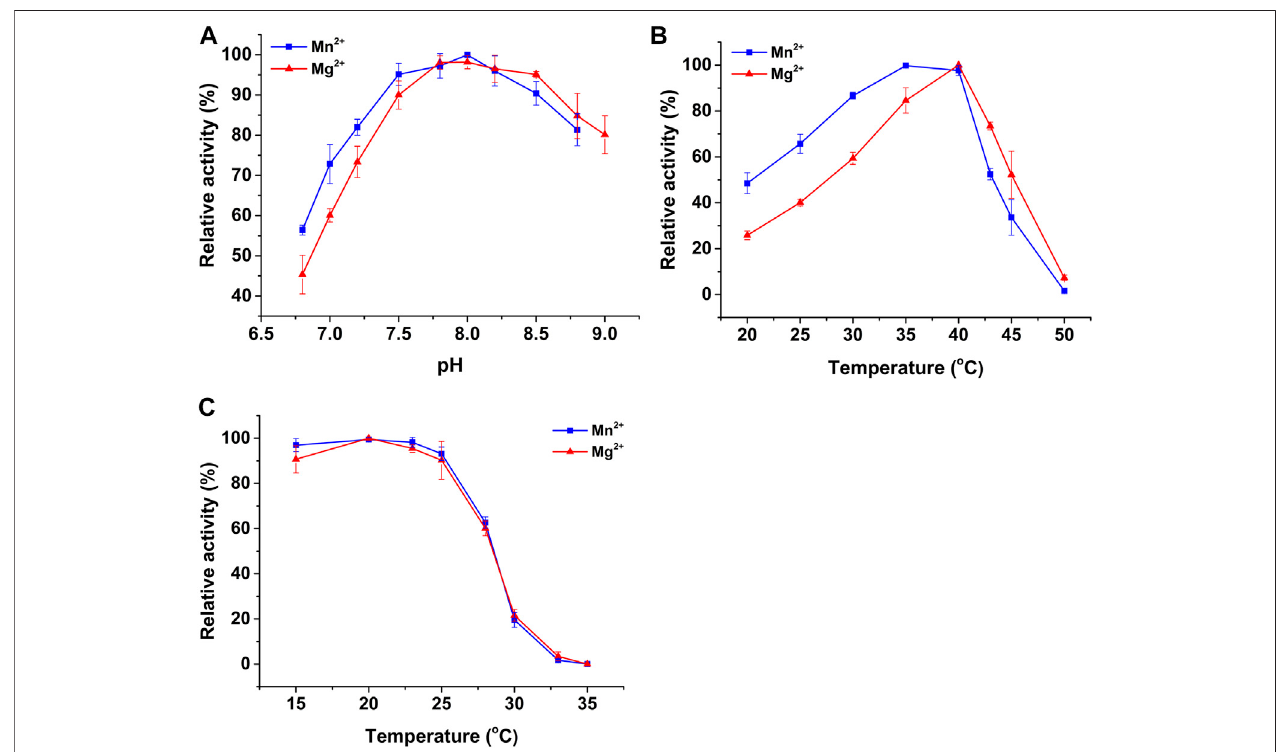
FIGURE 4 | The effects of pH and temperature on the NADP + -linked activity of PtIDH2 in the presence of Mn 2+ (blue squares) and Mg 2+ (red triangles). (A) The effects of pH on the activity of PtIDH2. (B) The effects of temperature on the activity of PtIDH2. (C) Heat-inactivation pro fi les of PtIDH2. All values are displayed as means ± SD of at least three independent measurements.